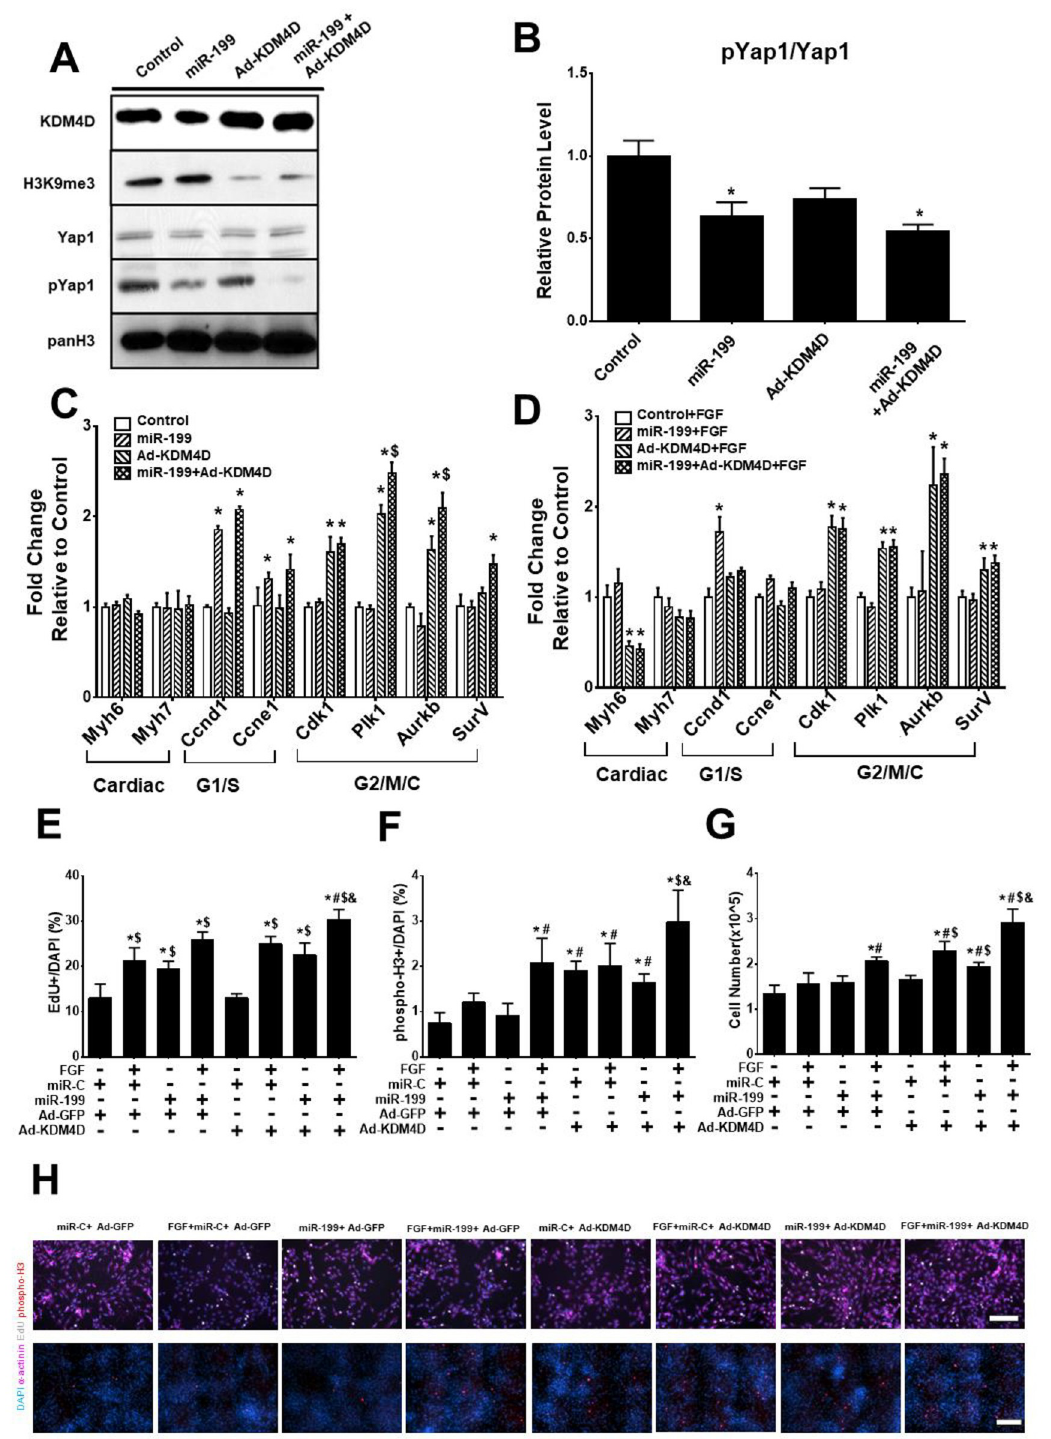
Fig 2. Effect of KDM4D and miR-199 on NRVM cell cycle activity. (A) Representative western blot of cell lysates from NRVMs treated with 5 days of Ad-KDM4D and 3 days of miR-199 (representative data from one of the three replicates). (B) Quantification of pYap1/Yap1 ratio from western blot. (C) RT-qPCR analysis shows the expression of cell cycle genes after 5 days of Ad-KDM4D and 3 days of miR-199 treatment. (D) The effect of FGF on KDM4D- and miR-199- stimulated cell cycle gene expression after 3 days (RT-qPCR assay). (E) EdU + incorporation in NRVMs treated with or without Ad-KDM4D, miR-199, and FGF. (F) pH3 +